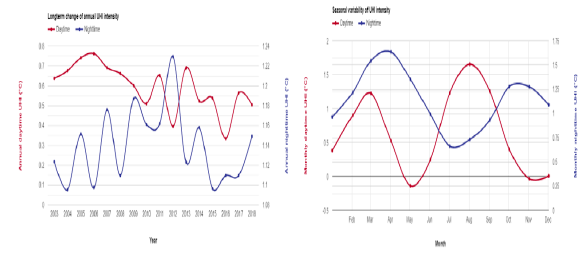
Figure 8: Annual and Monthly UHI Intensity